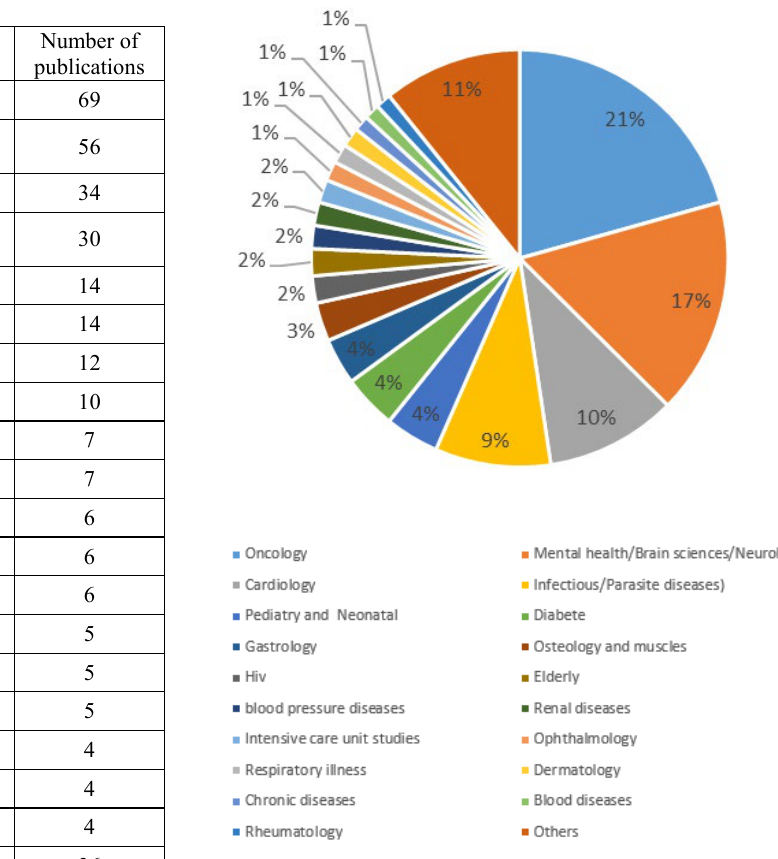
Figure 4. Distribution of publications per Family of